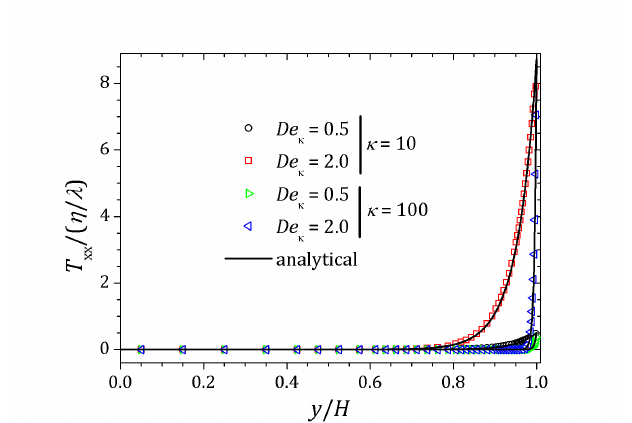
Figure 9. Normal stress for full PTT model. Results for κ = 10 e 100 and fixed parameters ε = ξ = 0.01.